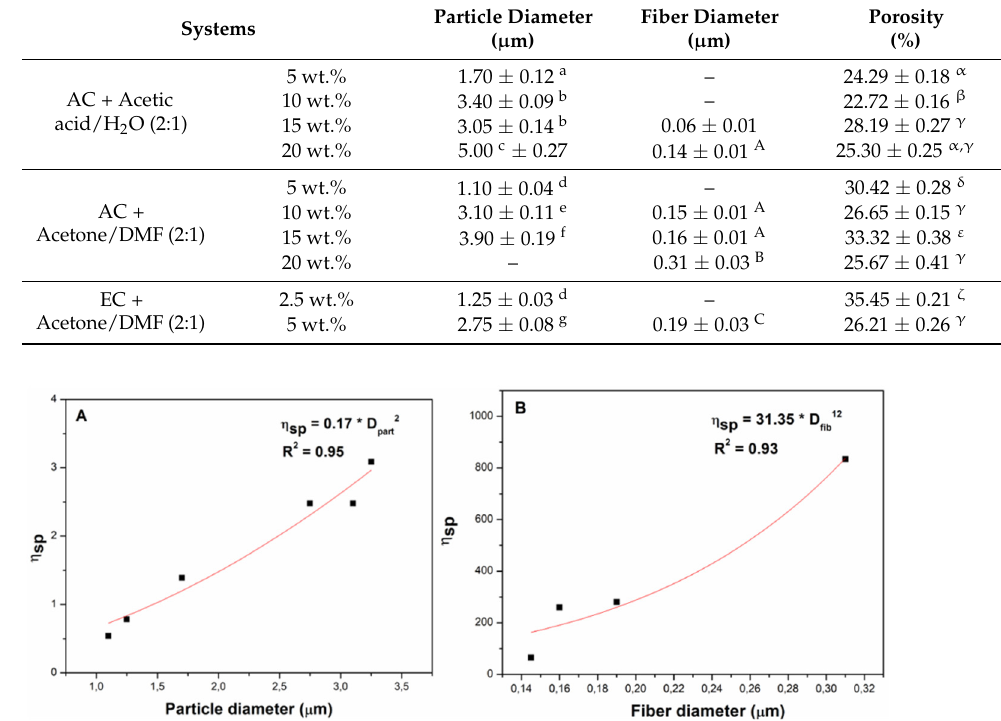
Figure 5. SEM images and distribution of microstructural properties of the nanostructures made with different EC concentrations ( A ) 2.5 wt.% and ( B ) 5 wt.%, using acetone and DMF as solvents.